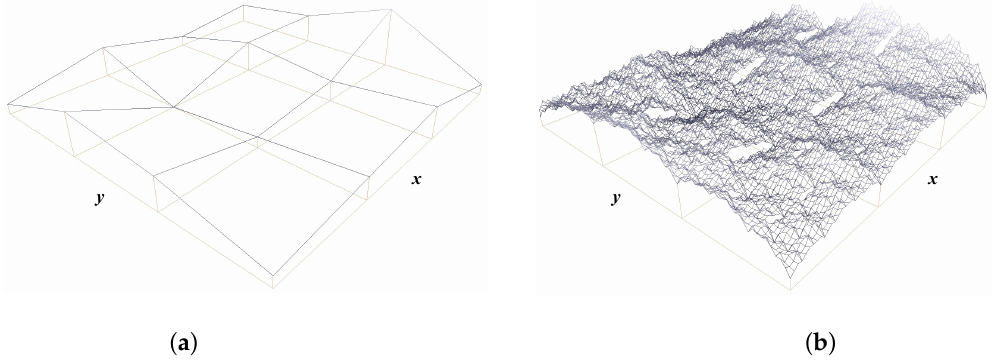
Figure 11. ( a ) The surface constructed with the original set of data. ( b ) The fractal interpolation surface.